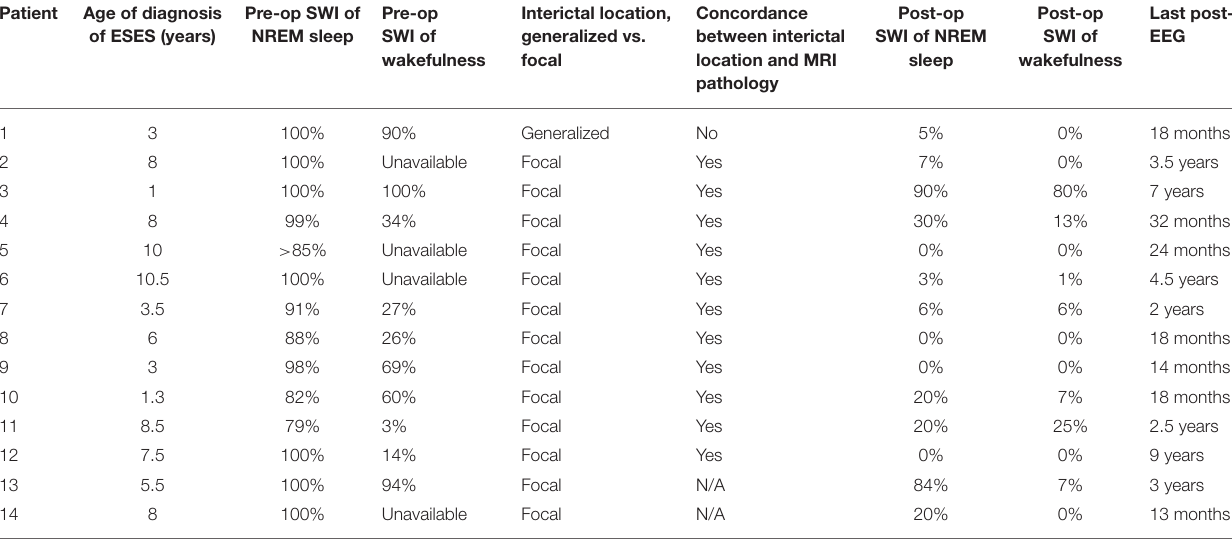
TABLE 2 | Pre- and post-surgical EEG features. Patient